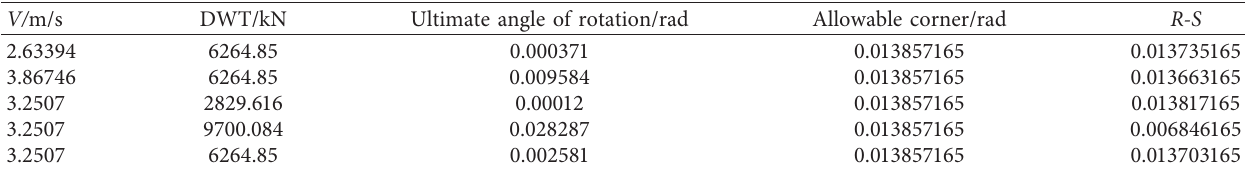
Table 7: iteration (at bridge formation).